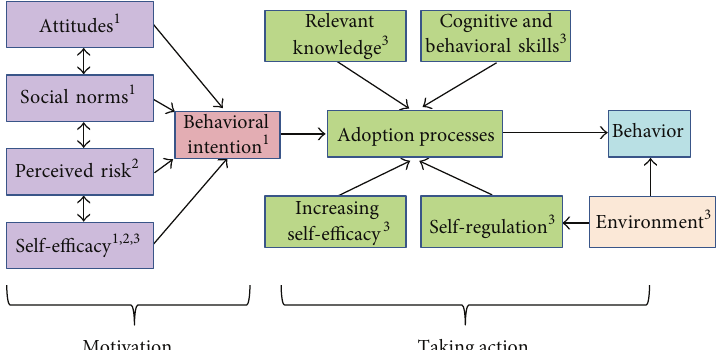
Figure 1: Theoretical model for the nutrition guidance system based on (1) Theory of Planned Behavior, (2) Health Belief Model, and (3) Social Cognitive Theory.